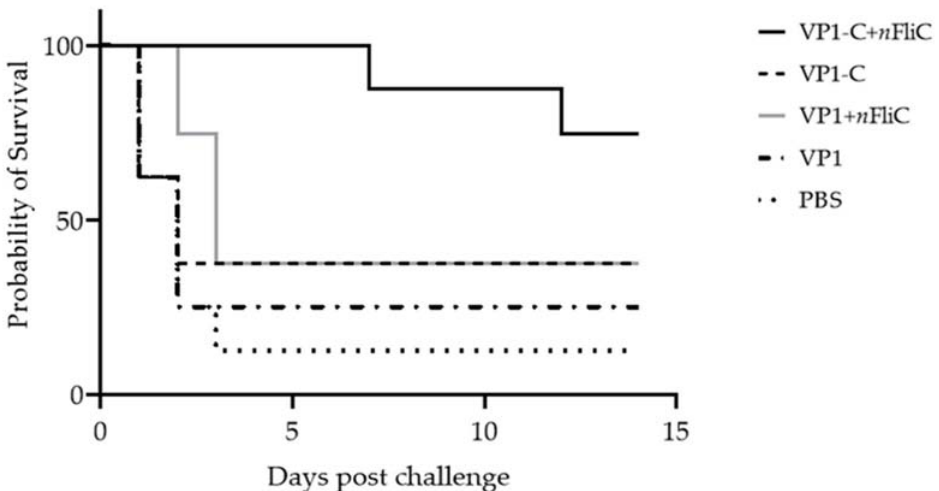
Figure 5. Survival rate of vaccinated ducklings after challenge with Duck hepatitis A serotype 3, NT01. Ducklings ( n = 8 per group) were vaccinated once with five different vaccine formulations: (1) VP1, (2) VP1 + n FliC, (3) VP1-C, (4) VP1-C + n FliC, and (5) PBS. Two weeks after